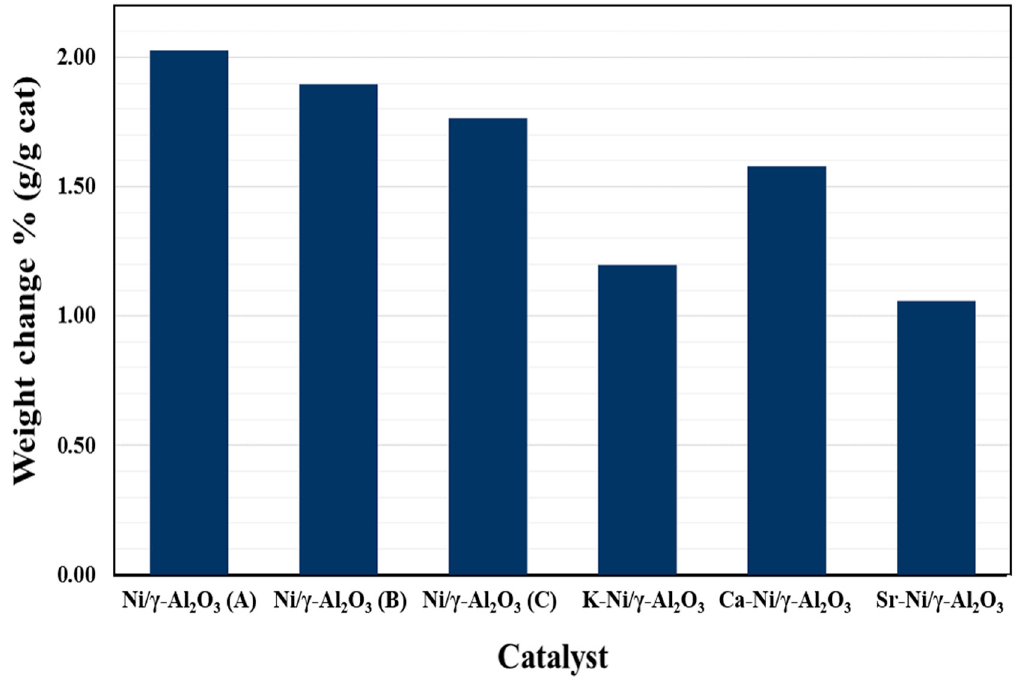
Figure 8. The TGA analysis for used catalysts in the SR of glycerol [83] (redrawn with copyright permission).